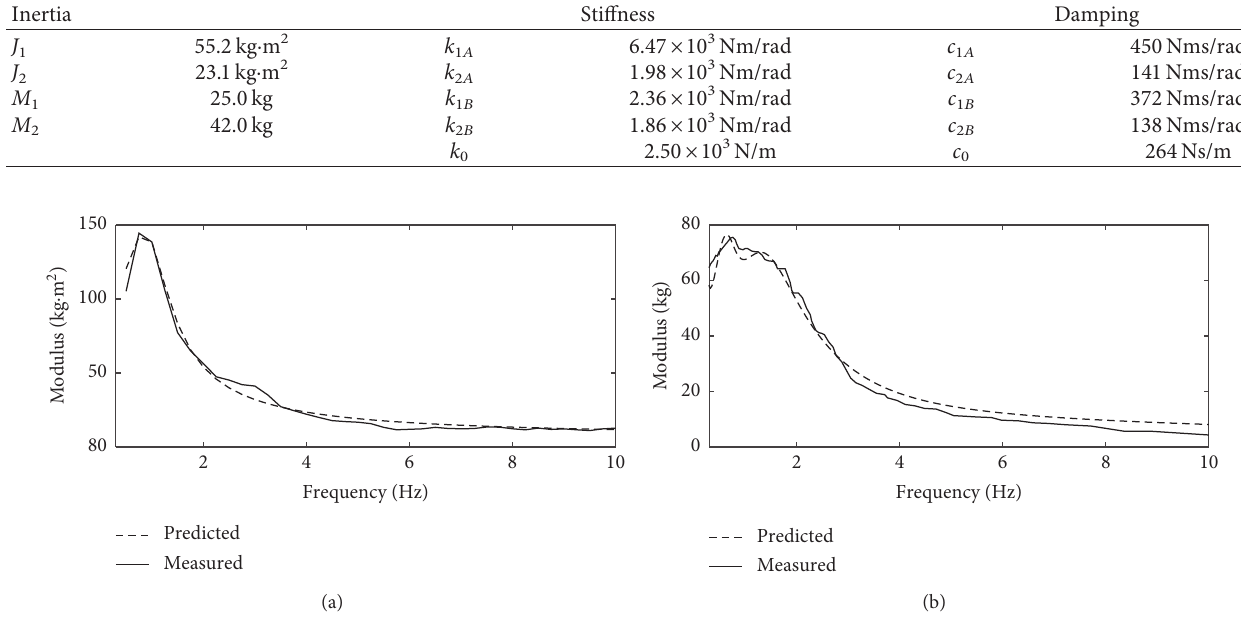
Figure 7: Measured and predicted apparent inertia by the model under. (a) Roll vibration and (b) lateral